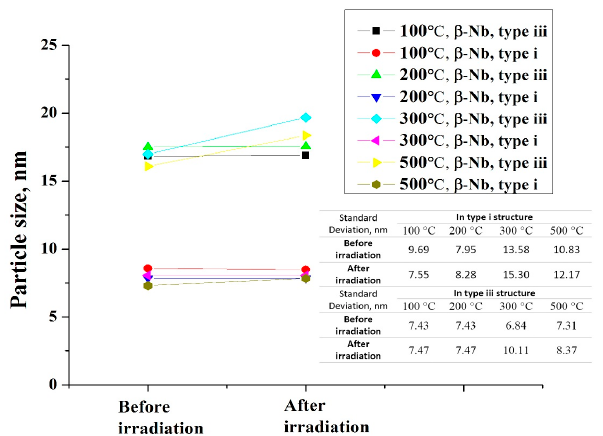
Figure 10. The size of β –Nb precipitates in type i and iii structures before and after irradiation at 100 °C, 200 °C, 300 °C, and 500 °C. The standard deviation of the measurements is inserted in the right corner.